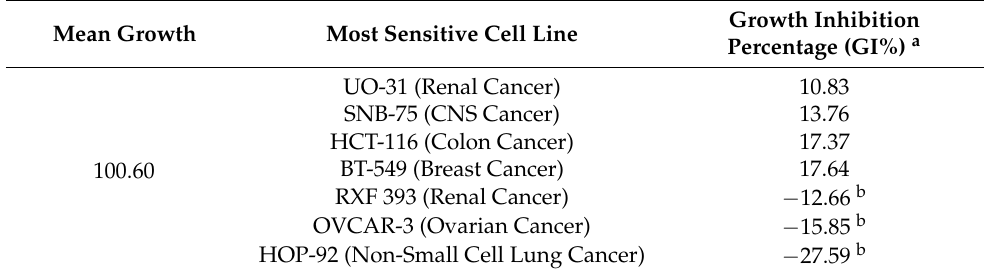
Table 2. Mean growth, GI%, and lethality values for the most sensitive human cancer cell lines displayed by the compound 3